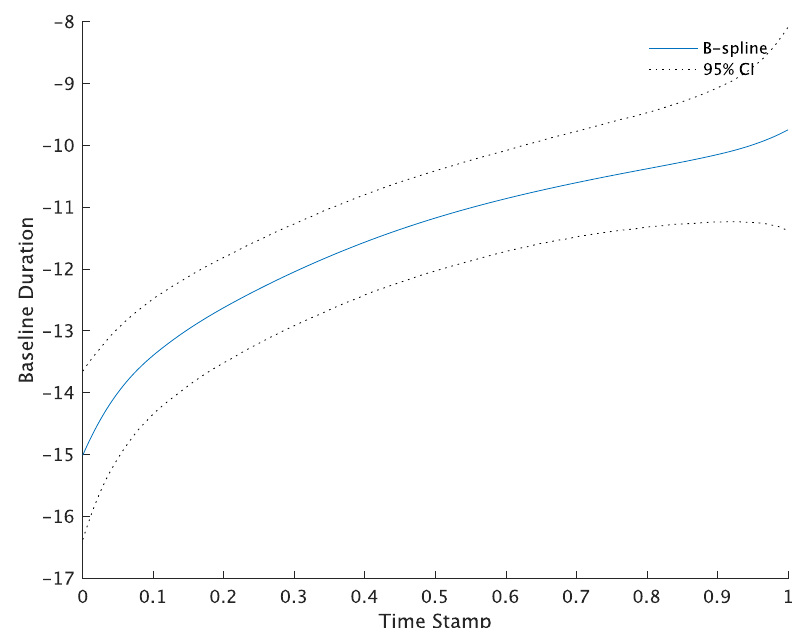
Figure 8. Intraday seasonality of time interval of JAL, Tokyo, Japan (23 June